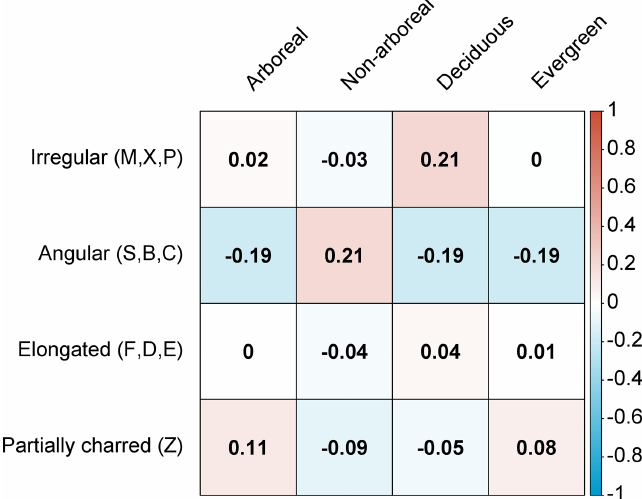
Figure B1. Correlations (Kendall’s τ ) of charcoal morphotype classes with selected pollen